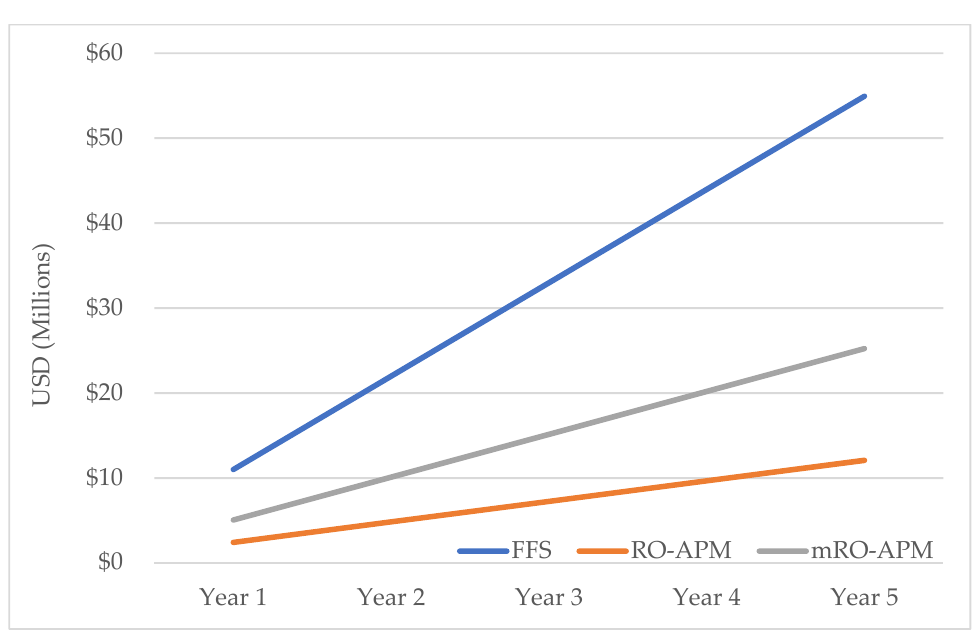
Figure 1. Projected annual reimbursement in millions USD across 5 years under each reimbursement model.